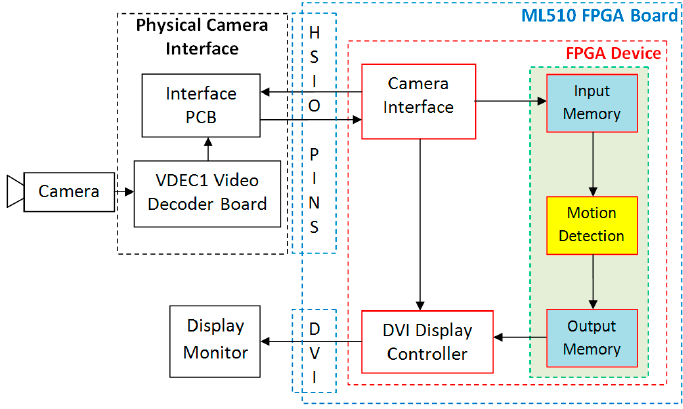
Figure 5. Dataflow diagram of the proposed and developed motion detection system.